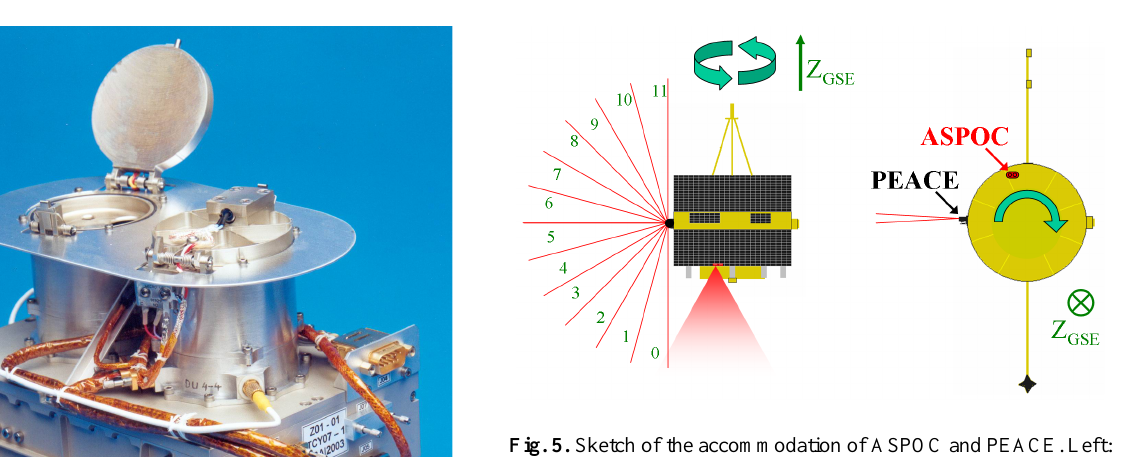
Fig. 5. Sketch of the accommodation of ASPOC and PEACE. Left: side view of spacecraft, spin axis points close to Z GSE , the ion beam and the “look” directions of the 12 PEACE anodes are indi- cated. Right: bottom view of spacecraft, showing the positions of ASPOC and